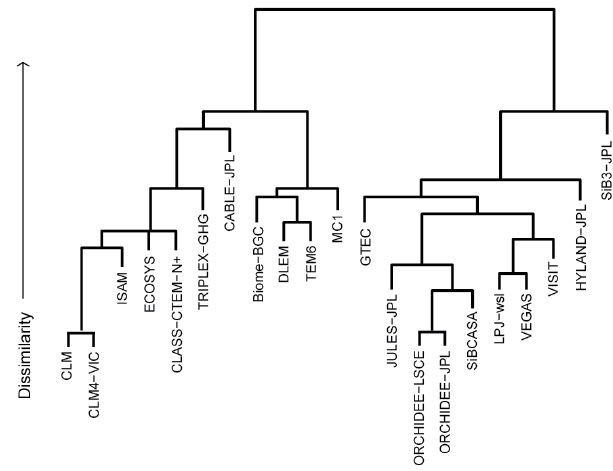
Figure 2 Fig. 2. Dendrogram showing overall model structural differences determined by Hamming distance for the models participating in MsTMIP. Models in the same “tree” share similar structural model characteristics. For example, models in the “tree” to the left include an explicit nitrogen cycle, while models in the “tree” to the right do not. Models are further separated or clustered by their treatment of soil carbon pools (e.g., SiB3-JPL does not include live, soil, or litter carbon pools) and their treatment of radiation and canopy heat stor- age (e.g., Biome-BGC, DLEM, TEM6, and MC1 do not account for canopy heat storage, nor partition radiation into latent and sensible heat). Refer to the Supplement for the binary data used to create this